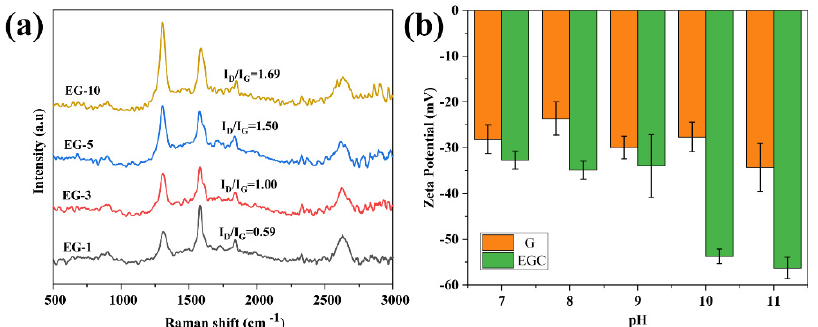
Figure 4. Raman spectra of samples with different heating–ultrasound times ( a ) and zeta potential of G/EGC ( b ). G denotes graphite; EGC denotes exfoliated graphite compound. G/EGC ( b ). G denotes graphite; EGC denotes exfoliated graphite